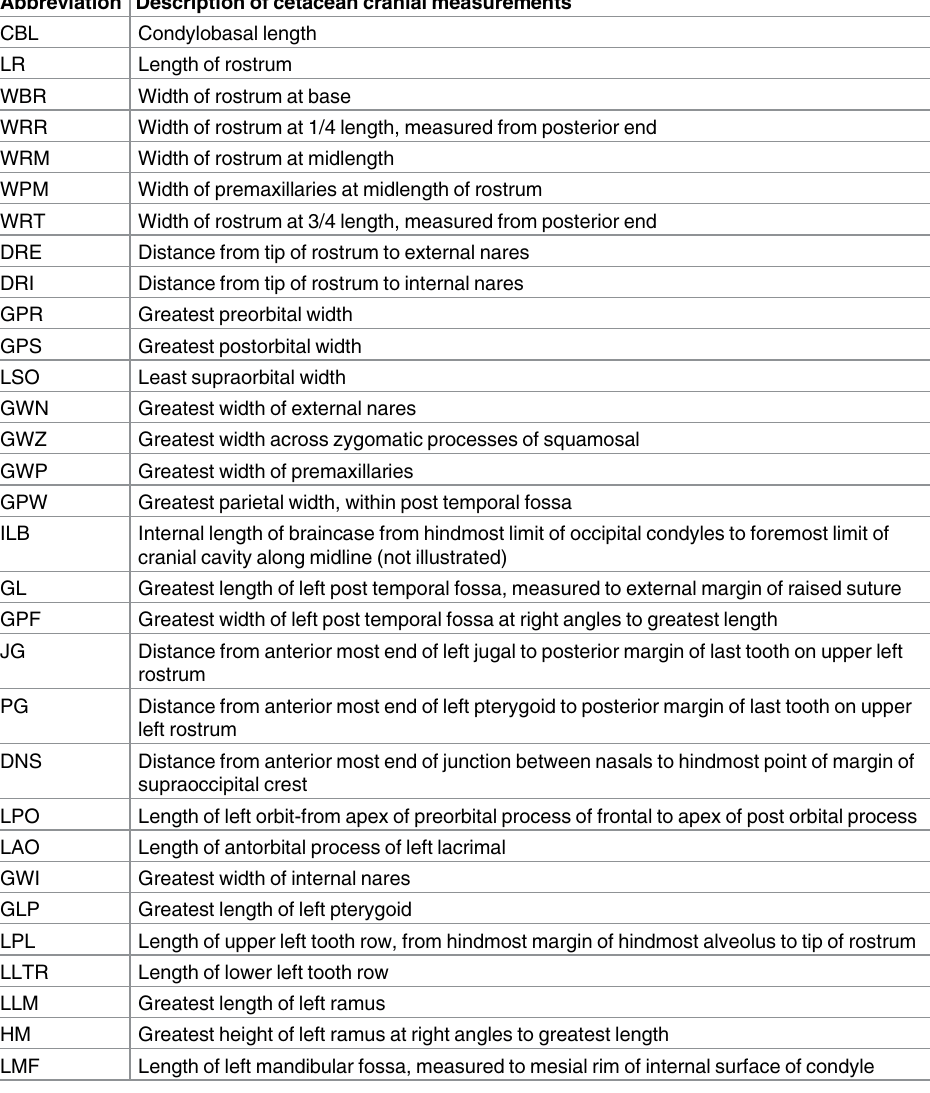
Table 1. Descriptions of cetaceancranial measurements in the present study. Abbreviation Description of cetacean cranial